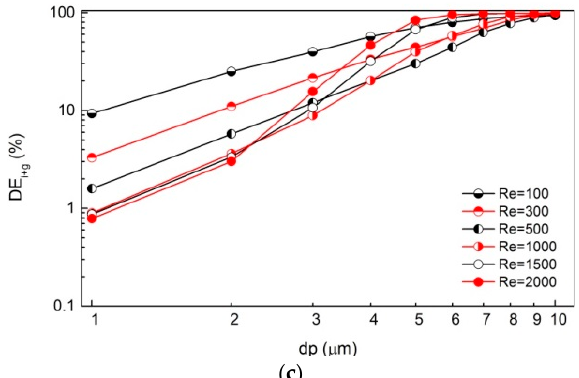
Figure 5. Particle deposition efficiency ( DE ) vs. particle diameter ( dp ) due to different mechanisms, including ( a ) inertial impaction; ( b ) gravitational sedimentation; ( c ) combined mechanism.